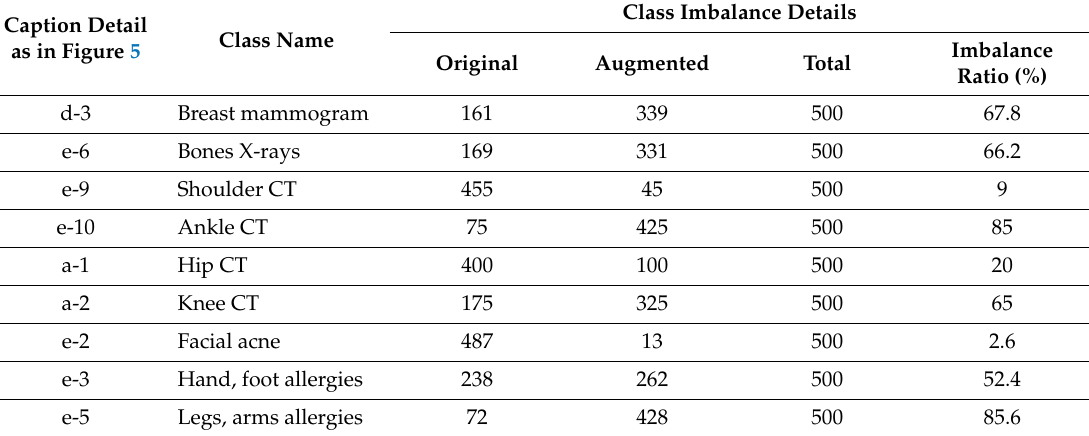
Table 4. Class imbalance details with augmented images for the classes which contain less than 500 images in training (unit: images).